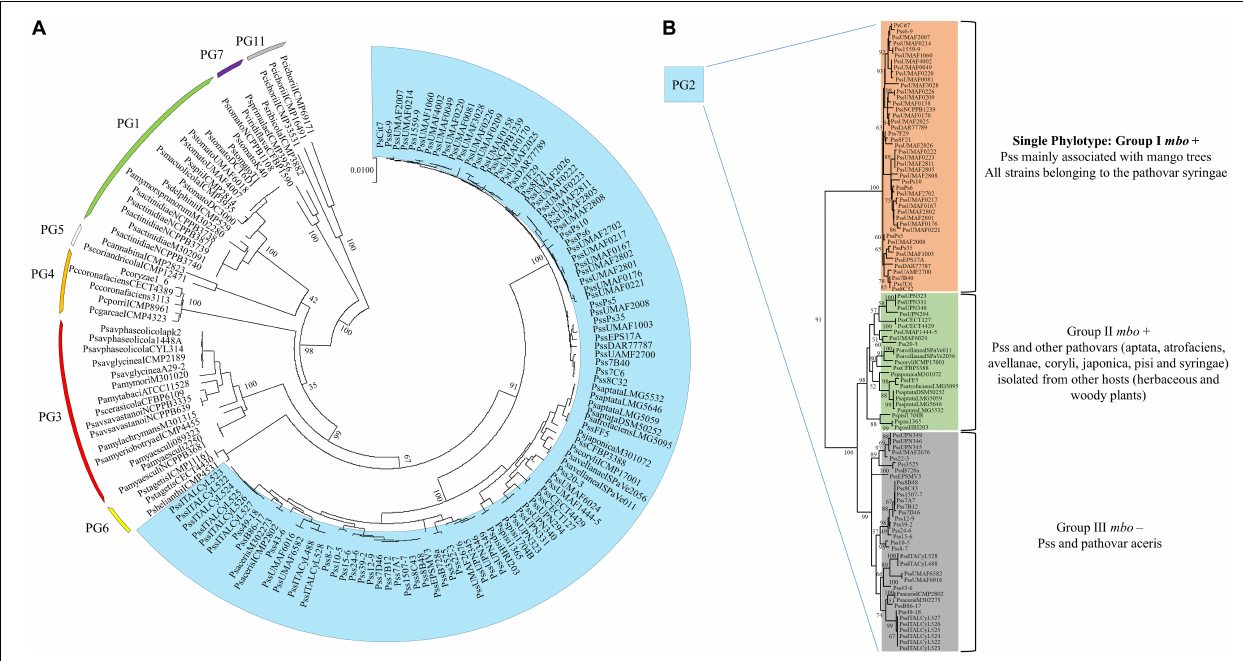
FIGURE 4 | Multilocus sequence typing analysis of strains belonging to the P. syringae complex. (A) The neighbor-joining tree was constructed with combined partial sequences of rpoD and gyrB housekeeping genes using MEGA 7 software. Bootstrap values (1,000 repetitions) are shown on branches and evolutionary distances are in units of nucleotide substitutions per site. One hundred and fifty strains belonging to the phylogenetic groups 1, 2, 3, 4, 5, 6, 7, and 11 of the P. syringae complex are depicted in the circular phylogenetic tree. Marked in blue are represented the strains belonging to the phylogenetic group 2, where the P. syringae pv. syringae strains isolated from mango are found. (B) Exclusive representation of the phylogenetic group 2. Three main groups are defined regarding the presence or not of the mbo genes necessary for mangotoxin production. The topology was similar among phylogenetic trees produced by the maximum-parsimony and maximum-likelihood methods. Supplementary Table S1 provides the phylogenetic groups, the host of isolation and the accession numbers of the DNA sequences used for each strain represented in this phylogenetic analysis.